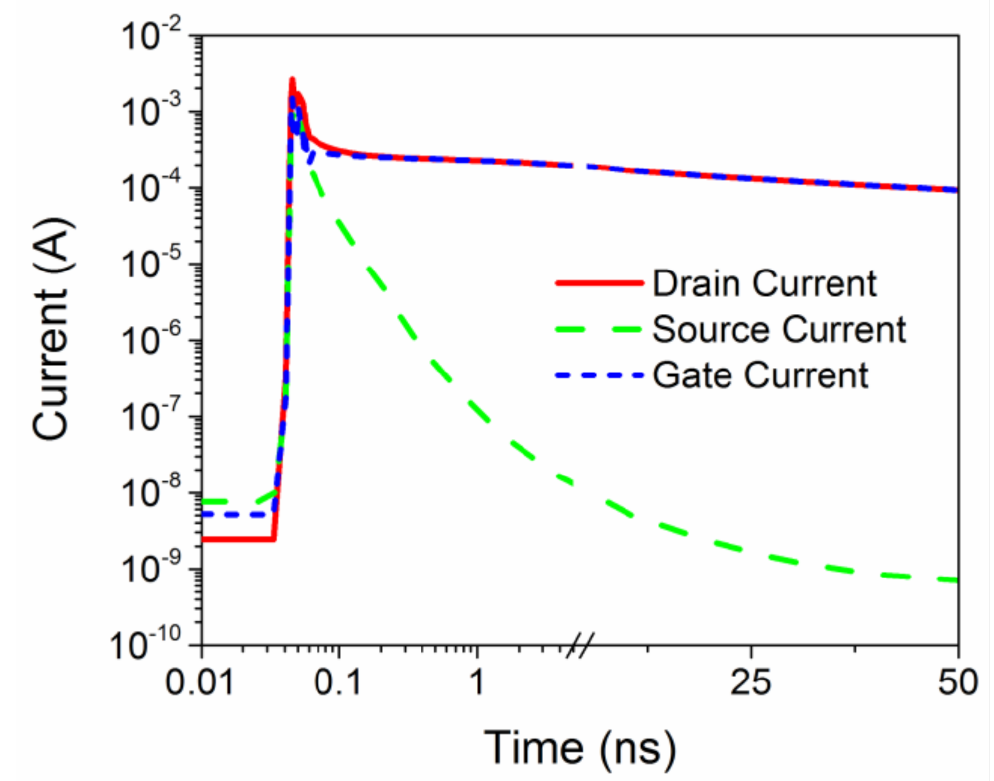
Figure 4. The transient drain, source, and gate currents after heavy-ion